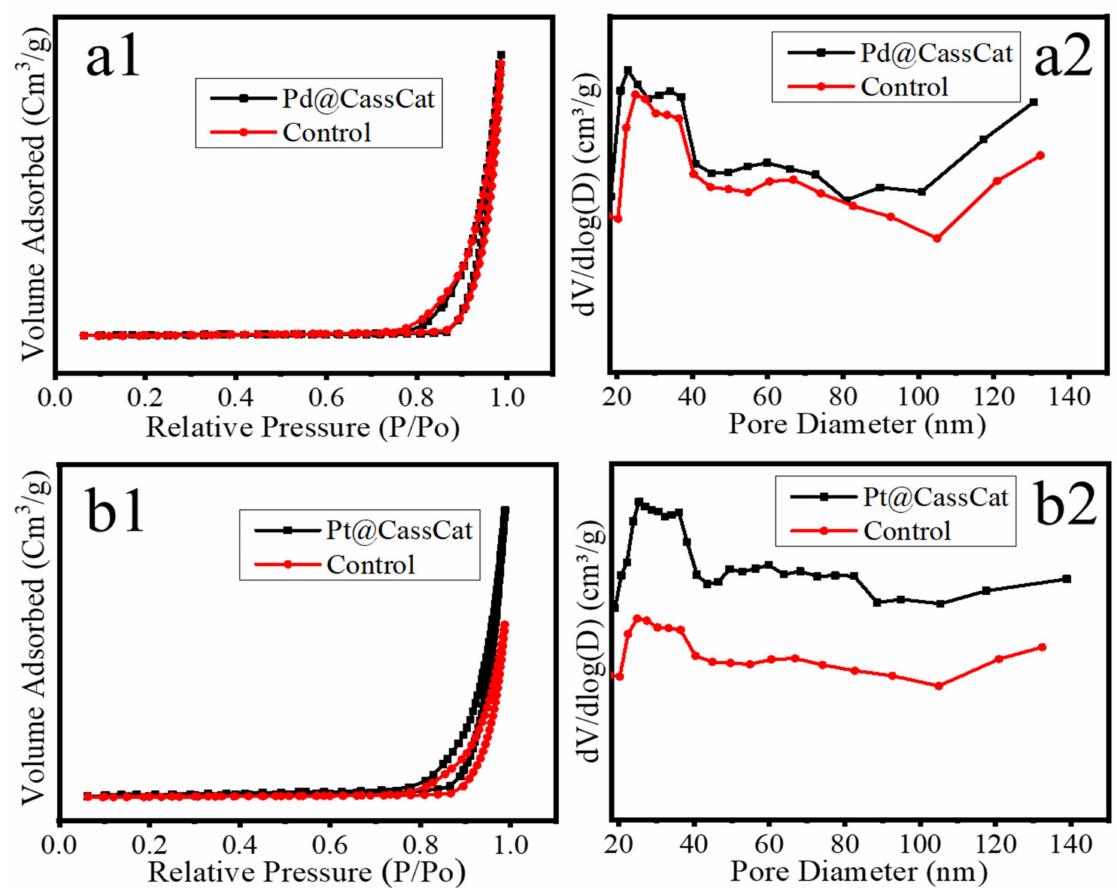
Figure 8. N 2 adsorption-desorption isotherms of ( a1 ) @PdCassCat, ( b1 ) @PtCassCat and control, and BJH pore size distribution of ( a2 ) @PdCassCat, ( b2 ) @PtCassCat, and control